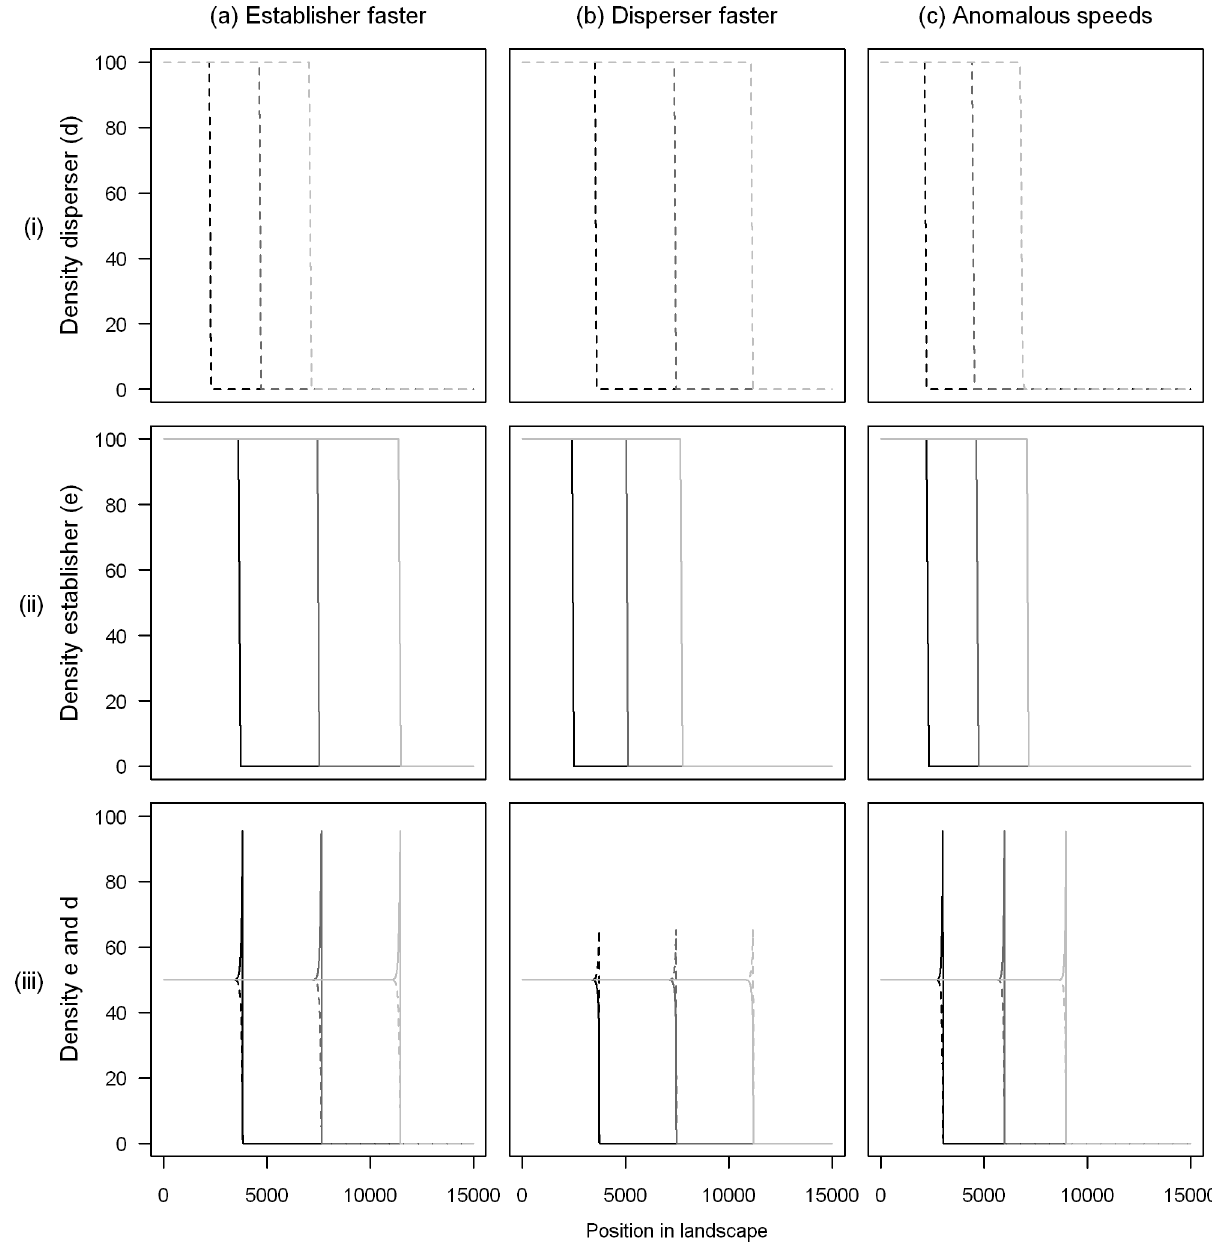
Figure 1. Invasion profiles of the two morphs. These show the disperser morph (dashed line) and establisher morph (solid line) when present in the landscape on their own (rows (i) and (ii)) and when mutation allows both to be present (row (iii)). The simulations were initiated with the first 100 cells occupied by each phenotype at its equilibrium population density and the remaining cells unoccupied. The simulations were run on a lattice consisting of 15000 cells. For all graphs each line represents the density profiles at a different time point, with each time point 500 units apart. In column (a) the polymorphic invasion speed is the same as the monomorphic establisher speed; in column (b) the polymorphic invasion speed is the same as the monomorphic disperser speed, and in (c) the polymorphic invasion speed is faster than either monomorphic invasion. For all simulations K ~ 100 , m ~ 0 : 01 , and in (a) r e ~ 0 : 8 , r d ~ 0 : 2 , D d ~ 0 : 6 , D e ~ 0 : 4 ; (b) r e ~ 0 : 6 , r d ~ 0 : 4 , D d ~ 0 : 8 , D e ~ 0 : 2 ; (c) r e ~ 0 : 8 , r d ~ 0 : 14 , D d ~ 0 : 8 , D e ~ 0 : 1 .